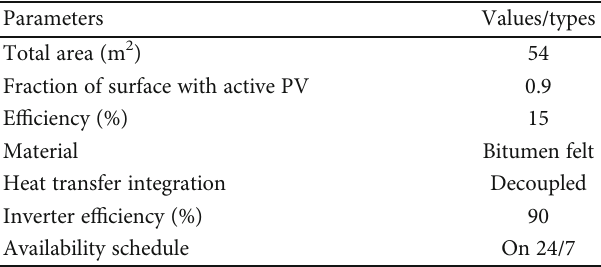
Table 2: Photovoltaic panel speci fi cations.